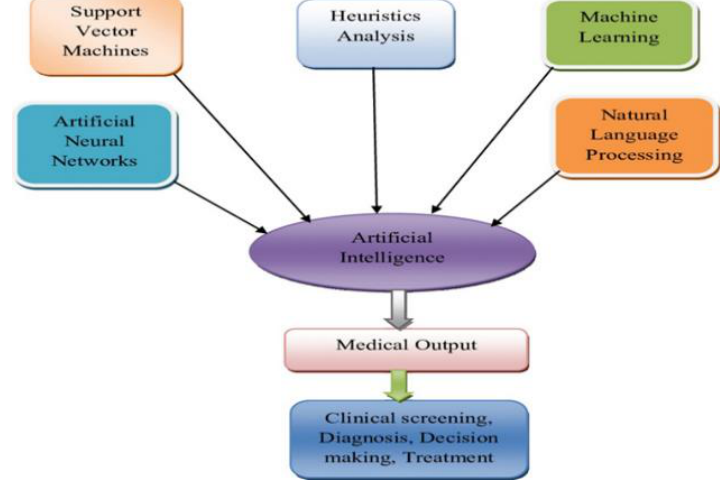
Figure 2. Process chart of artificial intelligence in the medical field.